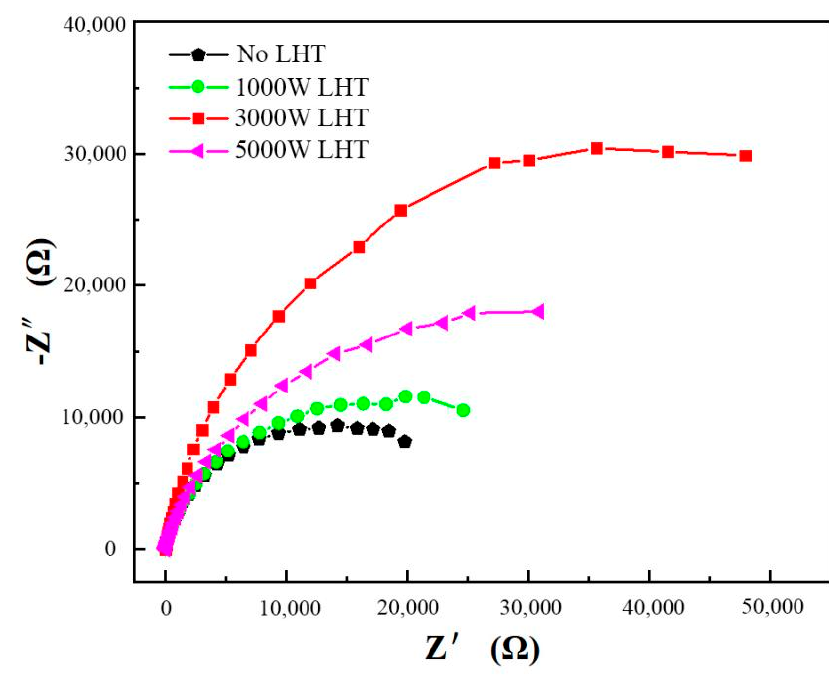
Figure 11. EIS curves of as-cladded and as-remelted DSS coatings.